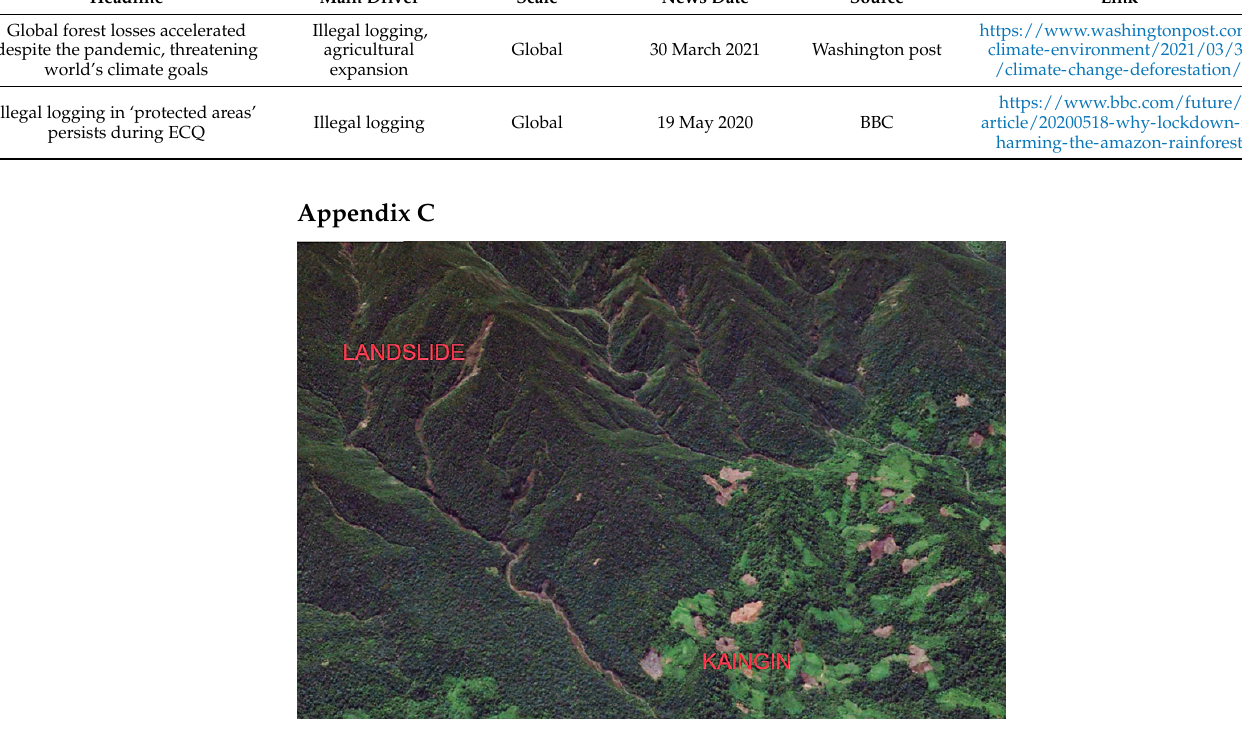
Figure A2. An example landscape in Southern Palawan where the forests are lost due to a landslide event and slash-and-burn areas. The latter is more situated in foot slopes of mountain areas. The image comes from Google Earth Pro and its terrain